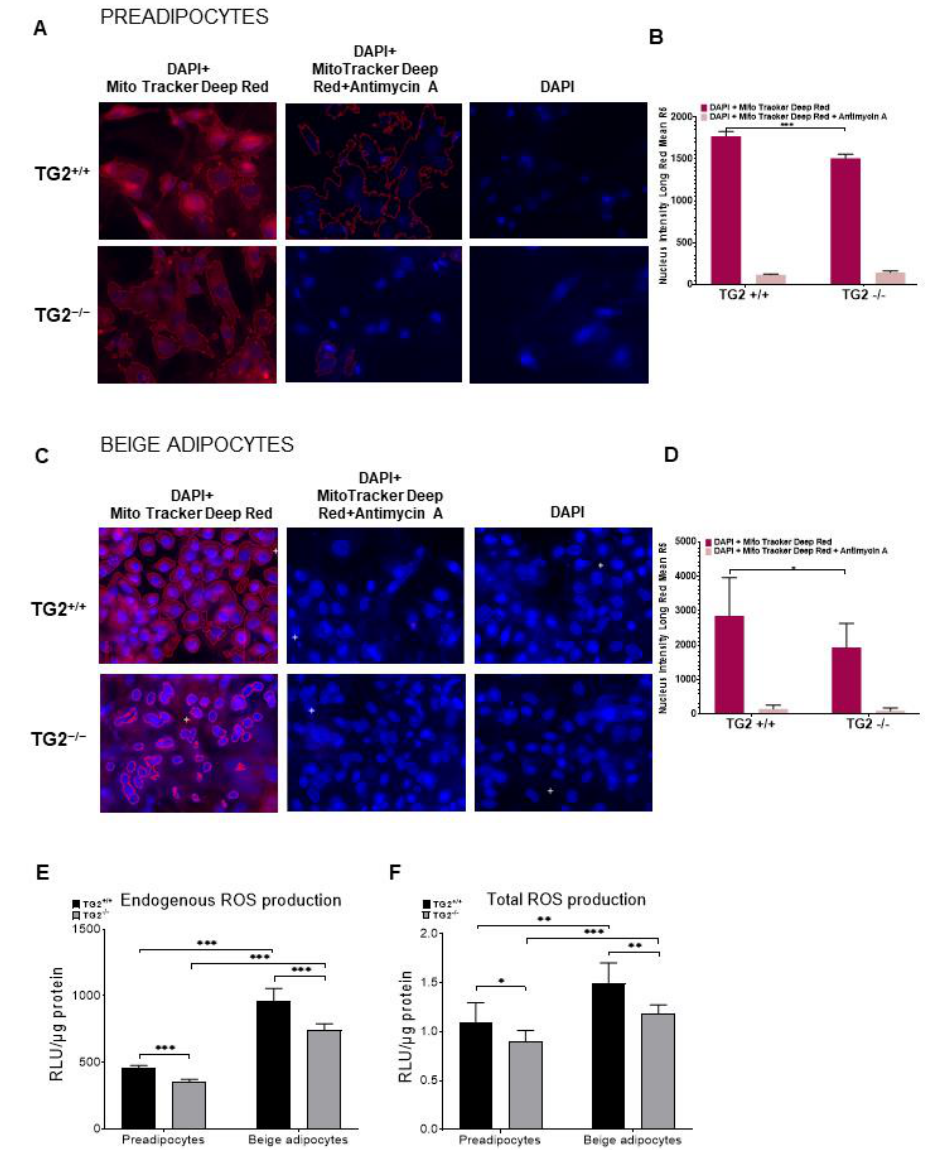
Figure 3. Mitochondrial membrane potential levels and ROS production in TG2 +/+ and TG2 − / − cells: ( A ) Representative laser scanning cytometry images of TG2 +/+ and TG2 − / − preadipocytes; ( B ) quantitative analyses of mitochondrial membrane potential in preadipocytes; ( C ) representative laser scanning cytometry images of TG2 +/+ and TG2 − / − beige cells; ( D ) quantitative analysis of mitochondrial membrane potential in beige cells, DAPI staining was used to determine the number of cell nuclei, cells were stained with Mito Tracker Deep Red either in the absence or the presence of 10 µ M antimycin; ( E ) endogenous and ( F ) total ROS production of preadipocytes and beige cells. Columns represent the mean values ± SD. Statistical analyses were performed using Student’s t